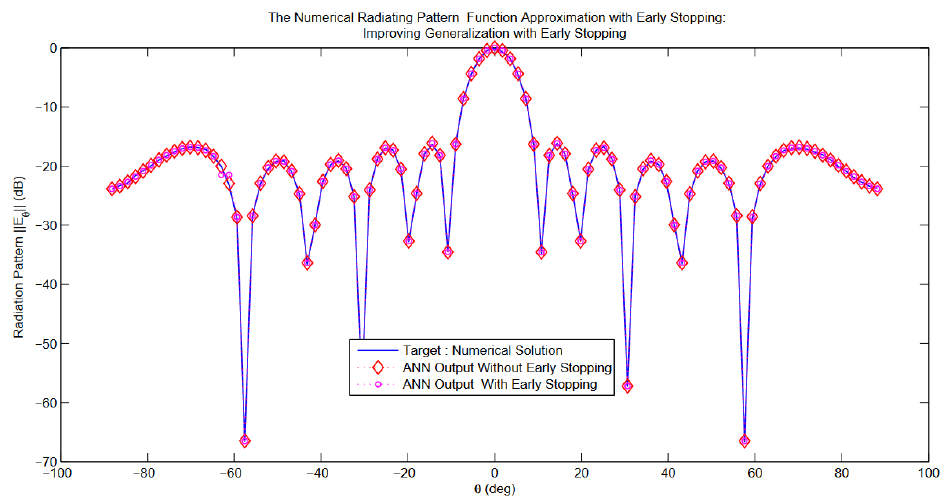
Figure 29. Radiation pattern function approximation with early stopping (ES): improving generaliza- tion with early stopping (ES). The parameters chosen to simulate the suggested almost periodic array antennas were: φ = 0 deg, N x = 3 elements, and d x = 2 λ = 108 mm (For periodic array example).